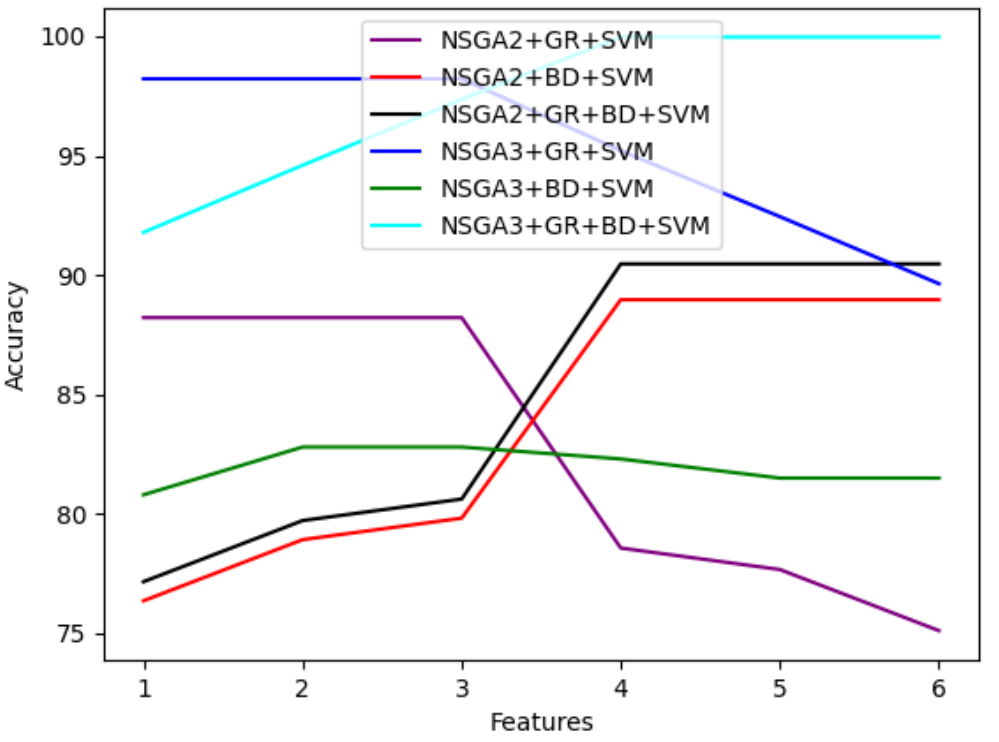
Figure 10. Performance comparison for NSGA2 and NSGA3 across filter-, wrapper- and hybrid-based feature selection methods.